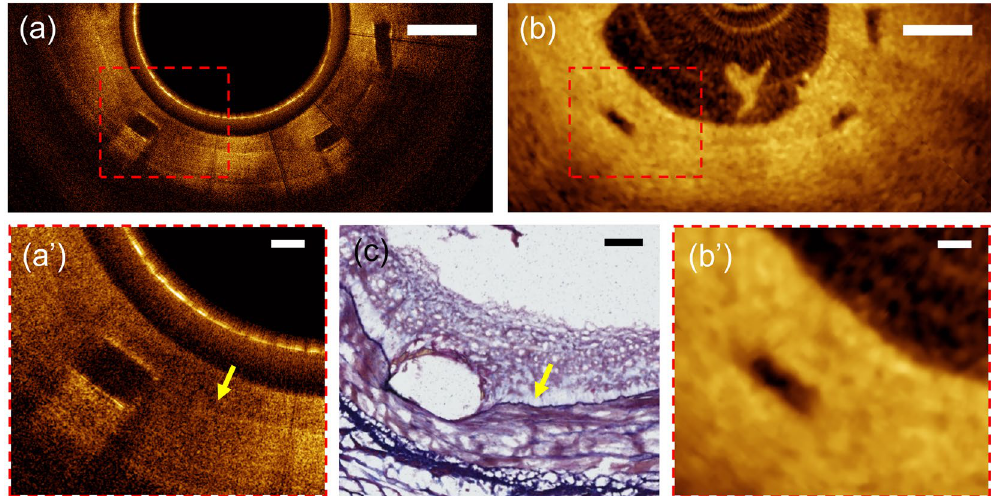
Figure 7. ( a ) μ OCT image of a BVS-implanted swine coronary artery (28 days post-implantation) and ( b,b’ ) corresponding cross-section of conventional OCT; ( a’ ) A magnified μ OCT image shows a thin highly-scattering IEL (arrow) that separates the medial layer and the strut-covering neointima; ( c) Corresponding histologic section stained with Verhoeff elastic-Masson trichrome; Scale bars for a and b, 500 μ m. Scale bars for a’, b’ and c, 100 μ